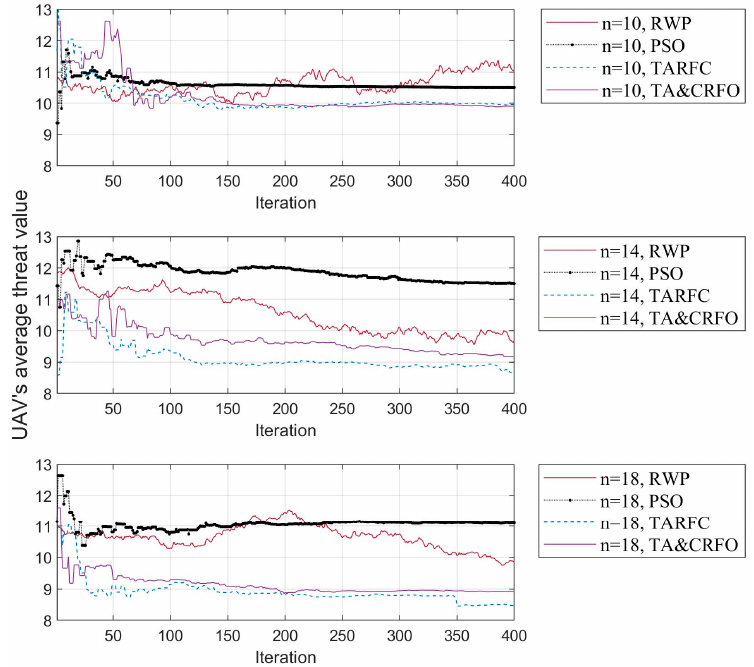
Figure 9. The UAV’s average threat fluctuation of different algorithms in the iterative process of FANET construction.